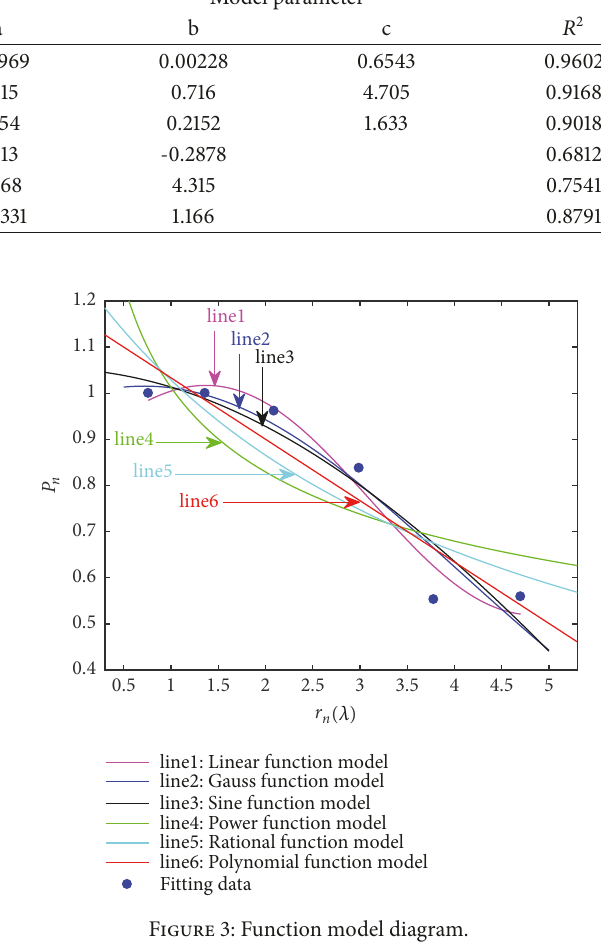
Figure 3: Function model